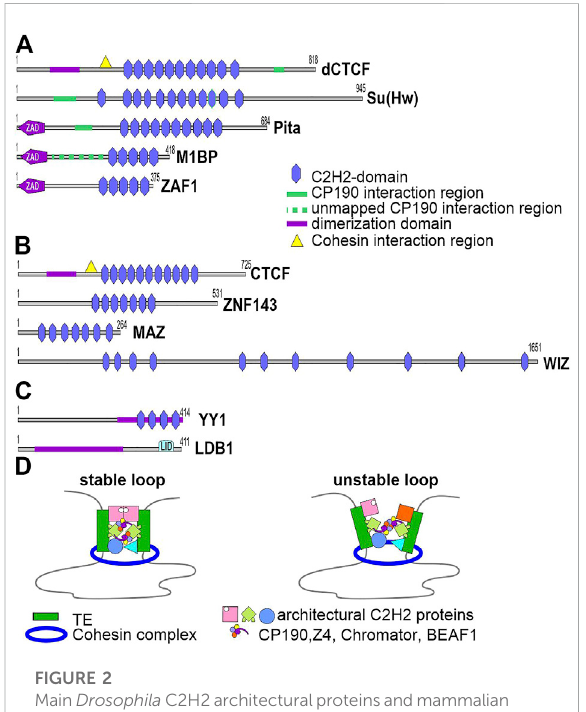
FIGURE 2 Main Drosophila C2H2architecturalproteinsandmammalian proteins involved in long-range interactions. (A) Schematic structuresofthe Drosophila C2H2architecturalproteinsstudiedin most detail: d S TCF, Su(Hw), Pita, M1BP, and ZAF1. Unstructured regions interacting with CP190 were precisely mapped in CTCF, Su(Hw) and Pita, but not in M1BP. (B) Schematic structures of human CTCF and the C2H2 proteins ZNF143,